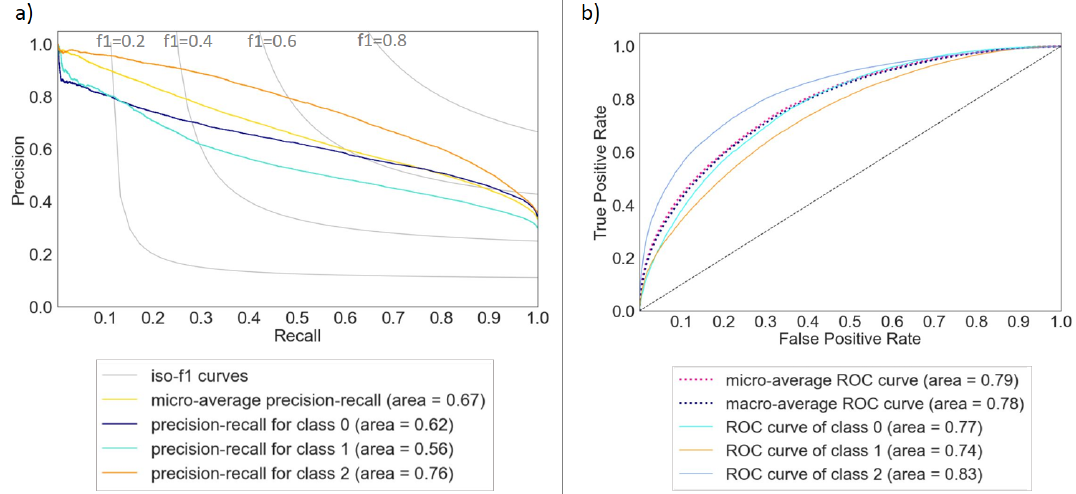
Figure 4. Gradient boosting simulation results: ( a ) precision–recall curve; ( b ) ROC